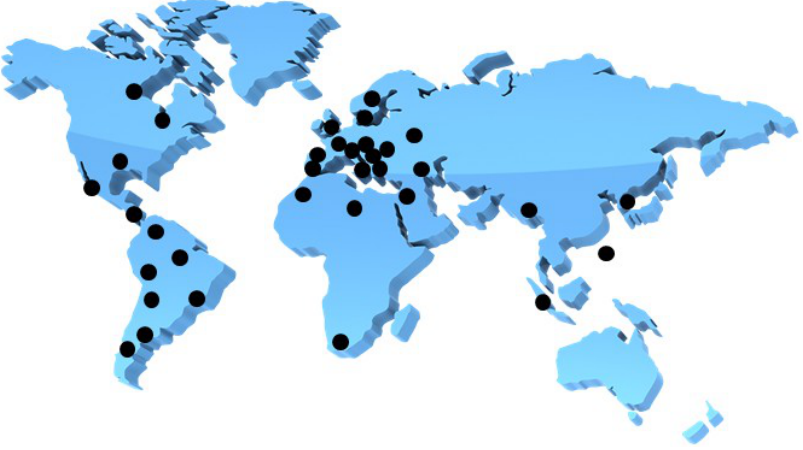
Figure 1. The global distribution of NDM-1 (adopted from reference